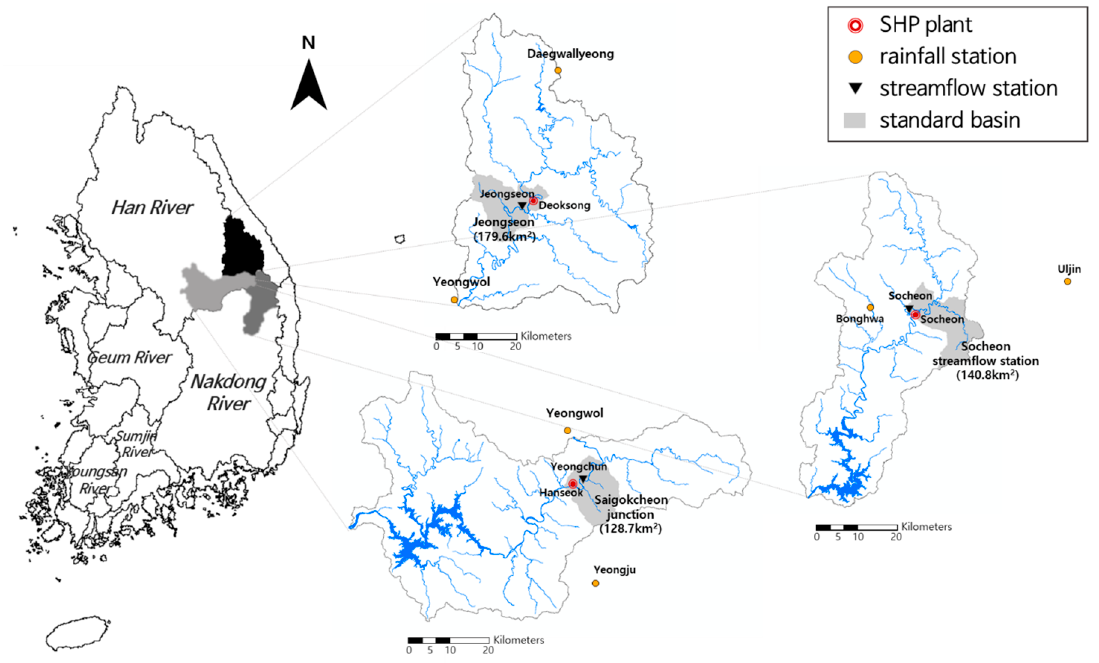
Figure 1. The taget basins, basin area, locations of small hydropower (SHP) plants, rainfall, and streamflow stations.